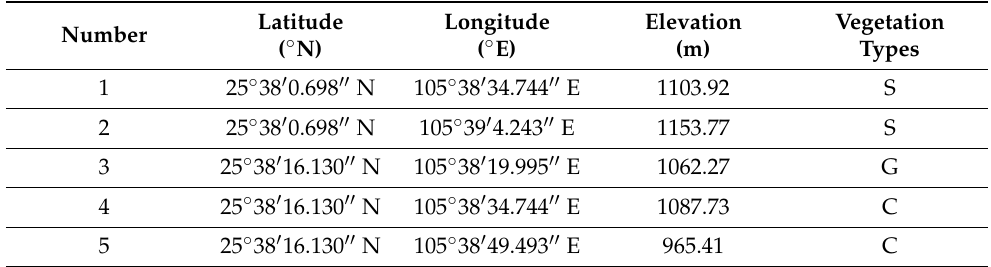
Table A1. Environmental information sheet for sampling